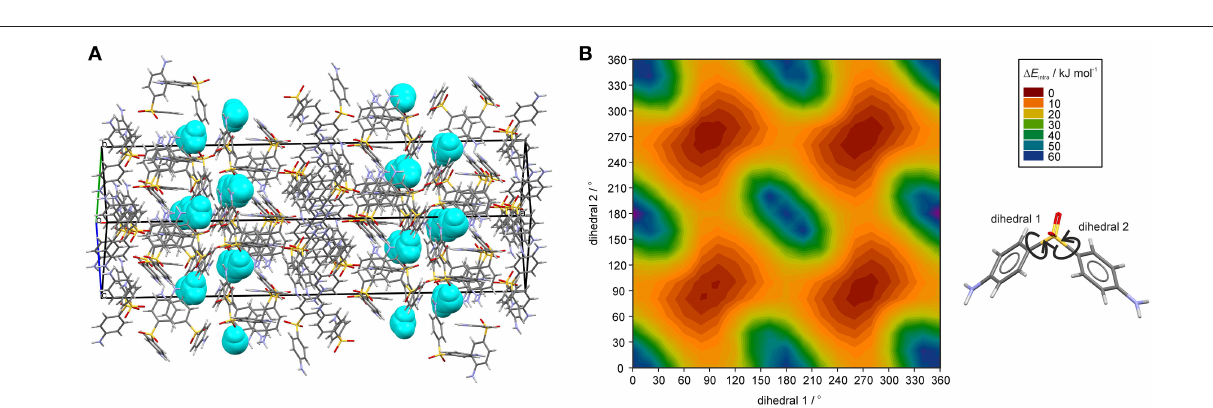
FIGURE 9 | (A) DDS 0.33-Hy structure (ANSFON02, Yathirajan et al., 2014), with water molecules depicted as space-fill in turquois, showing a possible water egress/ingress route parallel to [011]. (B) Two dimensional potential energy surface scan for DDS with respect to dihedrals 1 and 2 at the B3LYP level of theory with the 6-31G(d,p) basis set using the optimized DDS